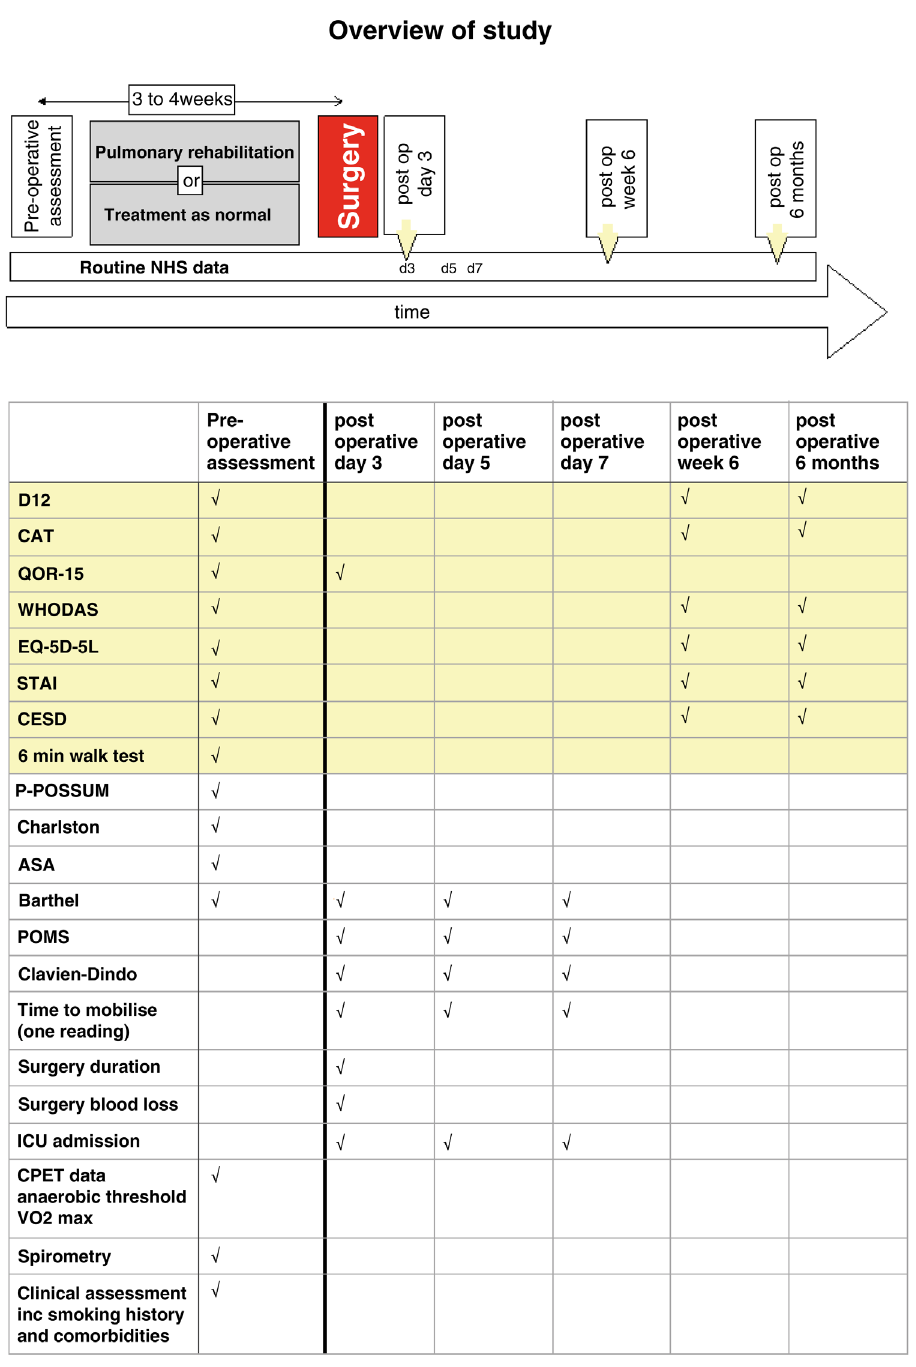
Figure 1. Overview of study methods. Data in yellow boxes is research data collected from the patient, whereas the data in pink relates to that collected from the patients’ clinical record. Abbreviations: NHS; National Health Service, D12; Dyspnoea-12 questionnaire, CAT; COPD assessment test, QOR-15; quality of recovery score, WHODAS; World Health Organisation (WHO) disability score, STAI; Spielberger state and trait anxiety inventory, CESD; Center for epidemiolgic studies depression scale, P-POSSUM; Portsmouth Physiological and Operative Severity Score for the enumeration of Mortality, Charlston; Charlston Morbidity Index, ASA; American Society of Anesthesiologists Physical Status Classification System, Barthel; Barthel scale, Clavien-Dindo; The Clavien-Dindo Classification of surgical complications, ICU; intensive care unit, CPET; cardiopulmonary exercise